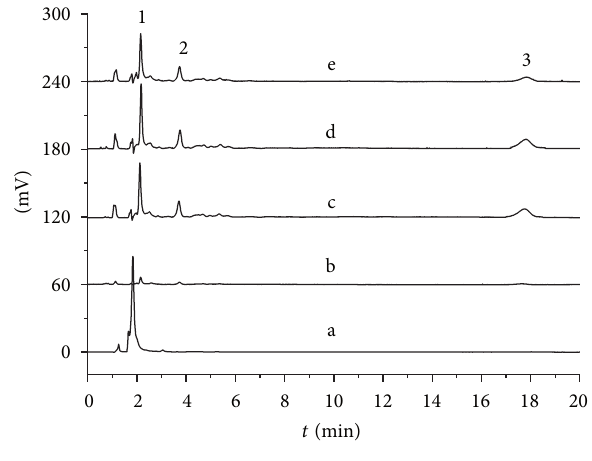
Figure 6: Comparative chromatograms obtained by analysis of the bottled sprite samples. Experimental conditions: mobile phase (ACN/H 2 O = 95/5, v/v), flow rate = 0.8 mL/min, 𝜆 = 224 nm, and injection volume = 20 𝜇 L. Peak orders: 1: DMP, 2: DBP, and 3: DOP; Symbols: a: original sprite sample without pretreatment, b: spited sample through NIP cartridge after spiting with DMP, DBP, and DOP at 0.3, 0.3, and 0.3 mg/L, respectively, c: sprite sample through MIP cartridge after spiting with DMP, DBP, and DOP at 0.3, 0.3, and 0.3 mg/L, respectively. d: standard solution, e: spited sample through PLS cartridge after spiting with DMP, DBP, and DOP at 0.3, 0.3, and 0.3 mg/L,